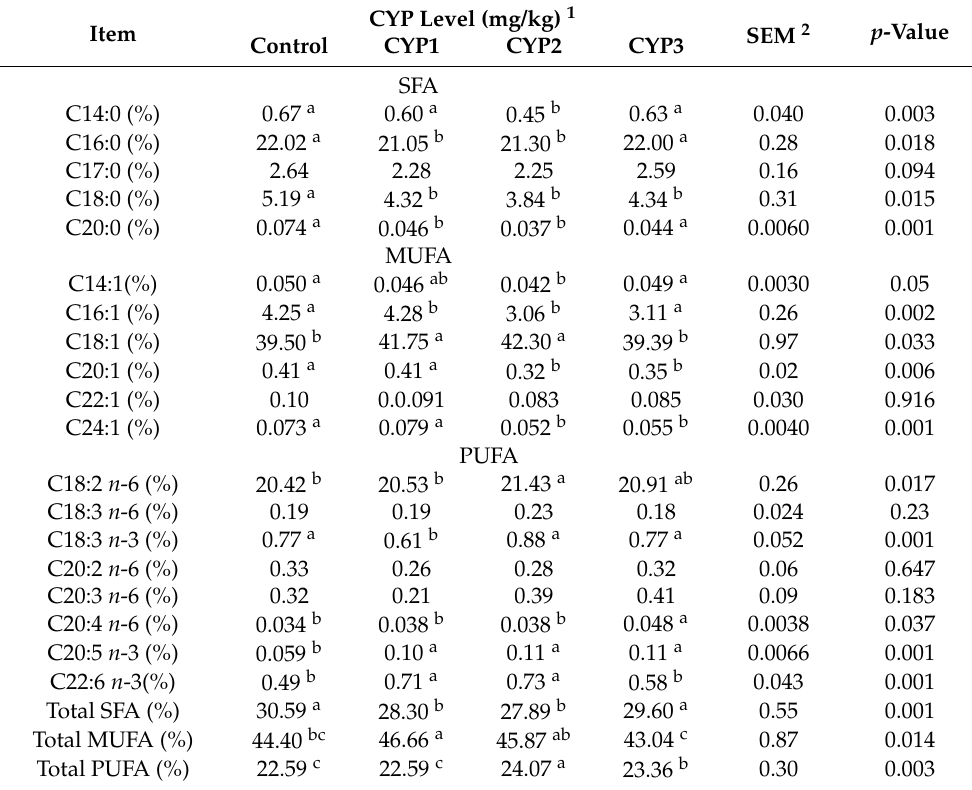
Table 5. Effects of CYP on fatty acids composition from thigh muscle in